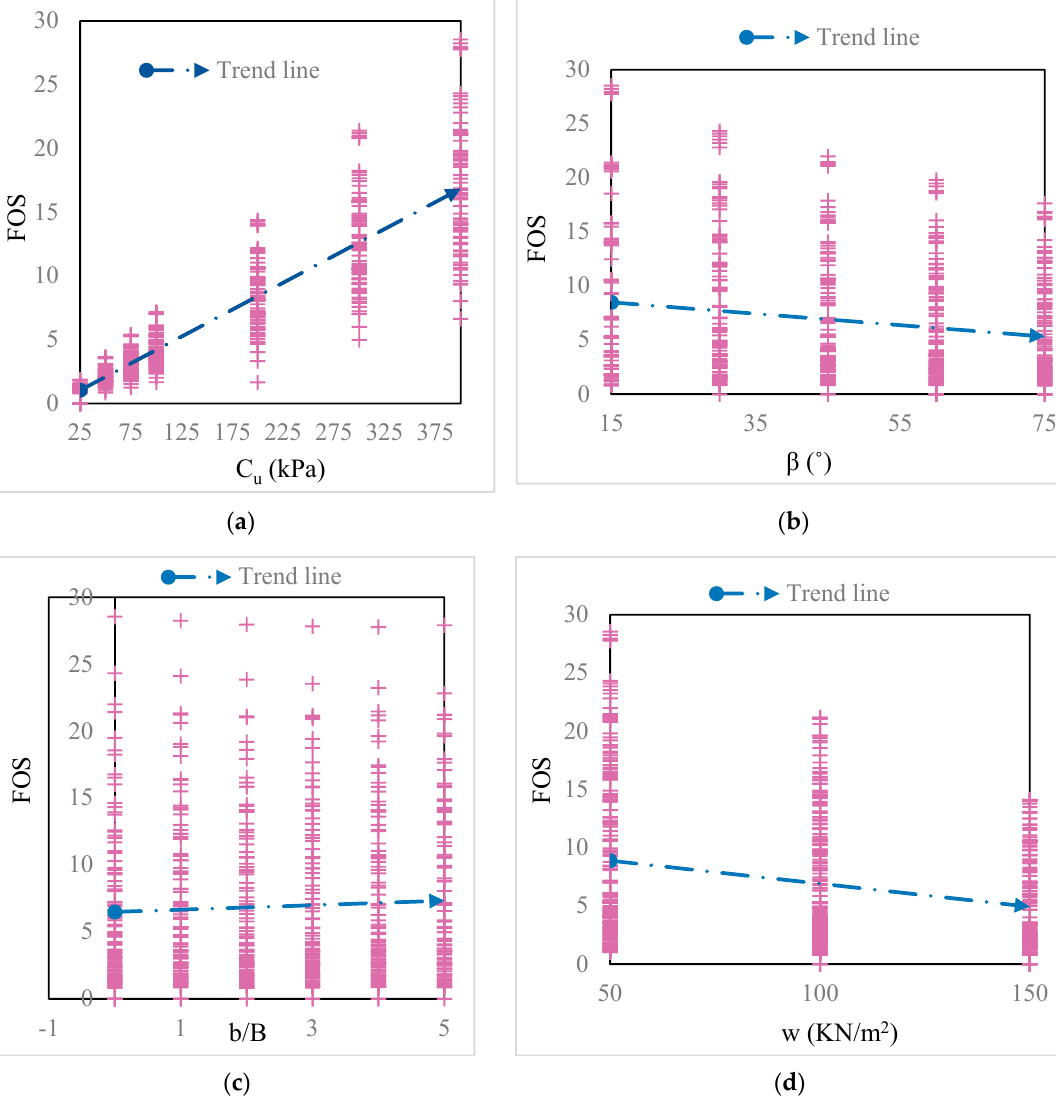
Figure 2. The relationship between the input parameters ( a ) strength of the soil (C u ), ( b ) slope angle ( β ), ( c ) setback distance ratio (b/B), and ( d ) applied surcharge on the footing installed over the slope (w) versus the obtained factor of safety (FOS).